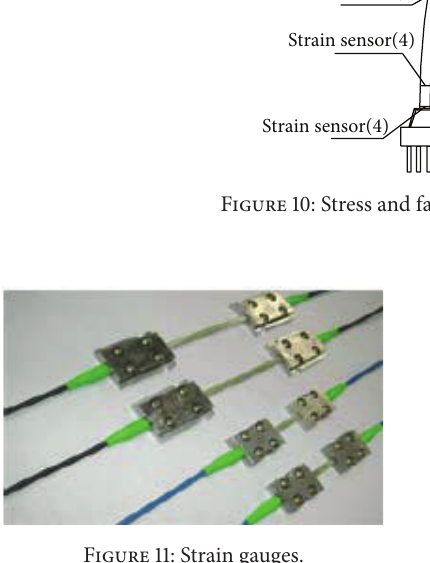
Figure 11: Strain gauges.